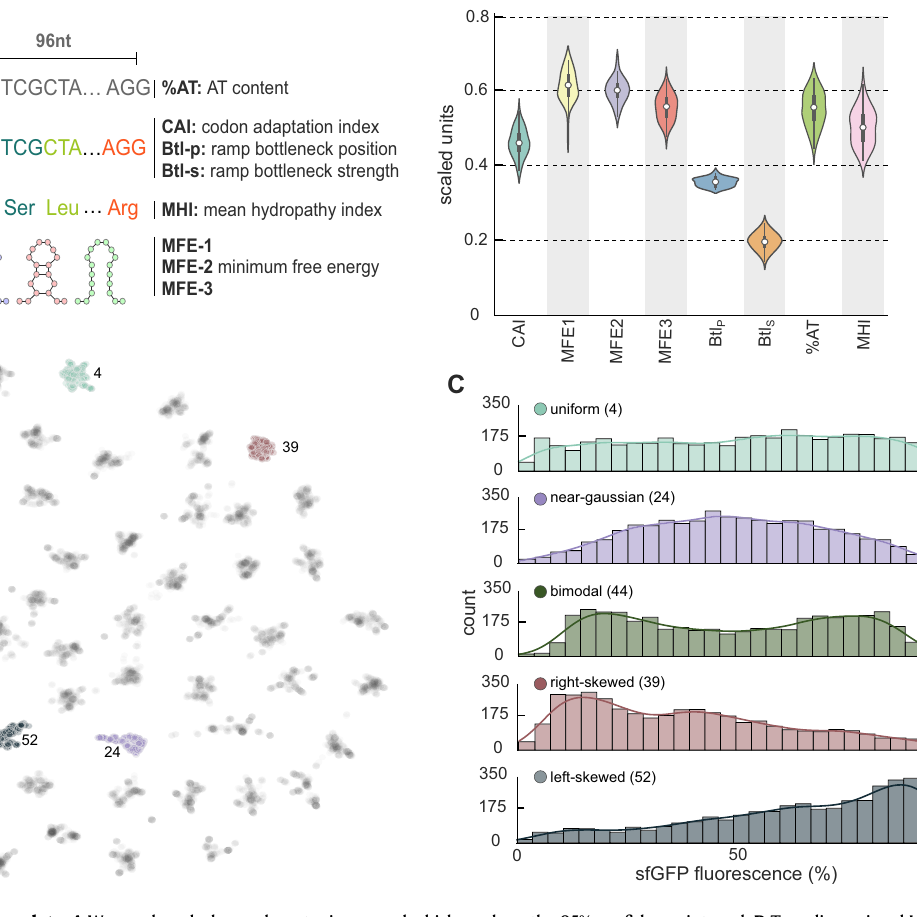
and whiskers show the 95% con fi dence interval. B Two dimensional UMAP 27 visualization of overlapping 4-mers computed for all 228,000 sequences; this representationreveals56clusters,witheachclustercorrespondingtoamutational series that locally explores the sequence space around its seed; we have high- lighted fi ve series with markedly distinct phenotype distributions (labels denote the series number). Other UMAP projections for overlapping 3-mers and and 5-mers are shown in Supplementary Fig. S1. C Mutational series with qualitatively distinct phenotypic distributions, as measured by FACS-sequencing of sfGFP fl uorescence normalized to its maximal measured value; solid lines are Gaussian kernel density estimates of the fl uorescence distribution. Measurements are nor- malized to the maximum sfGFP fl uorescence across cells transformed with the same construct averaged over 4 experimental replicates of the whole library 23 . Fluorescence distributions for all mutational series are shown in Supplemen- tary Fig.